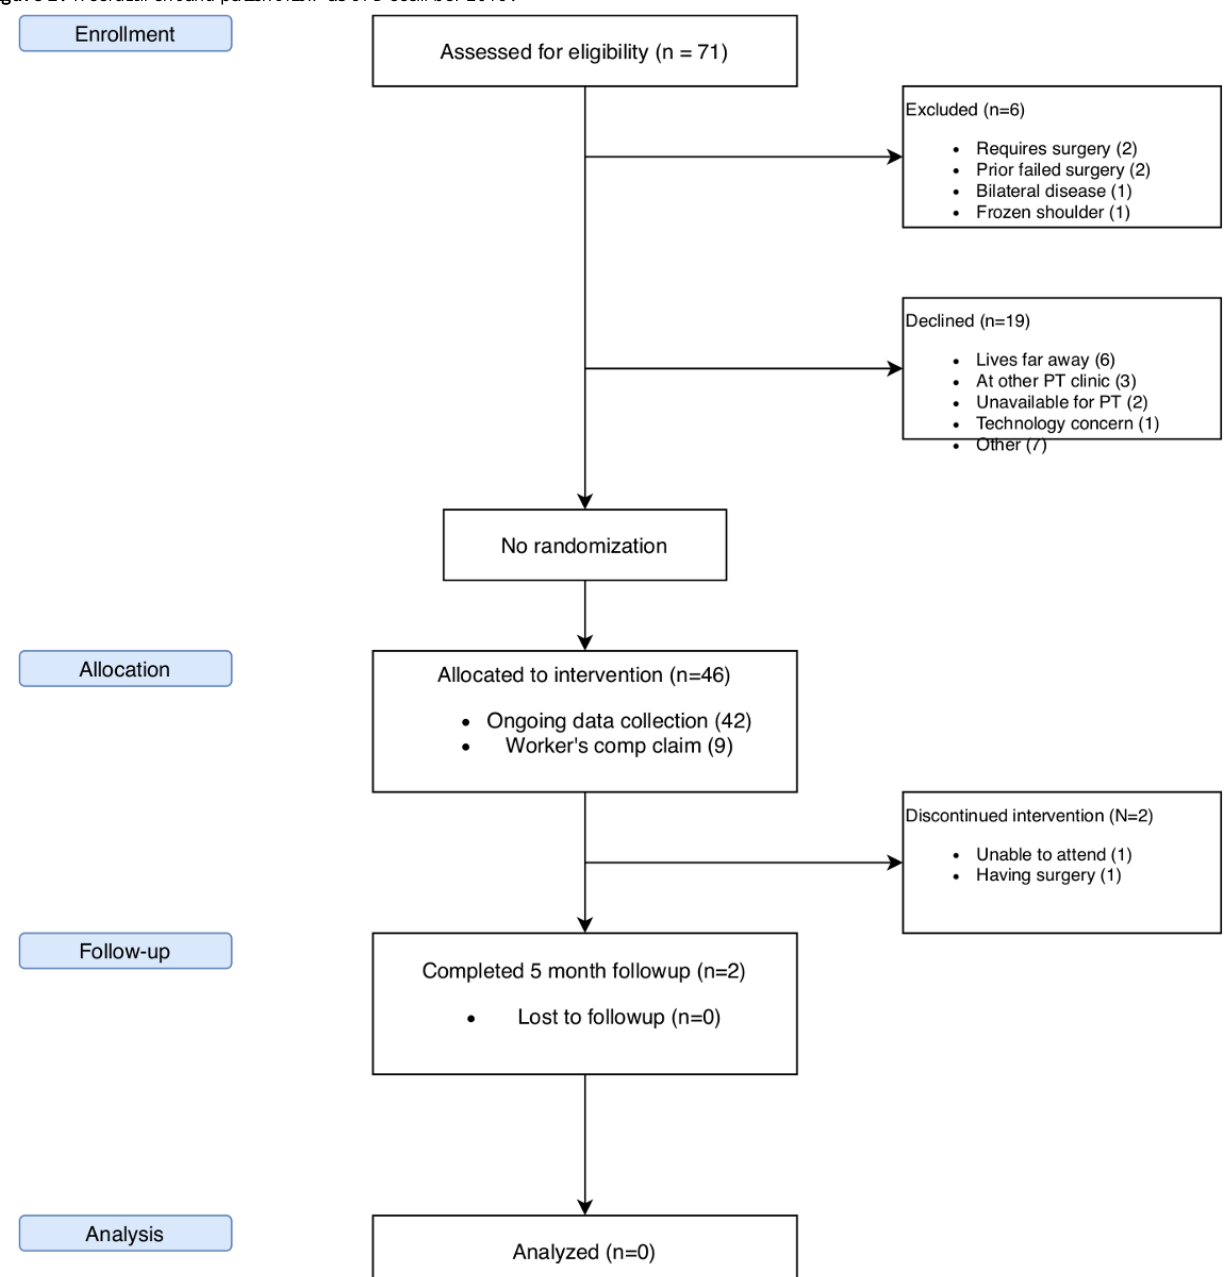
Figure 2. Recruitment and patient flow as of December